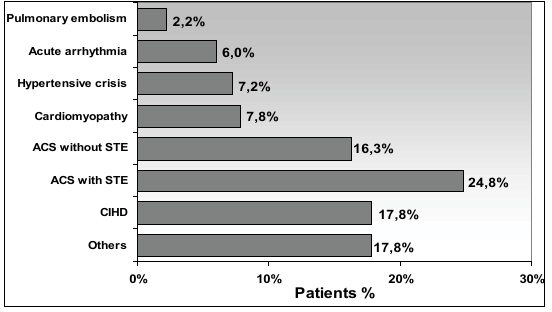
Table 1. Baseline characteristics. Figure 1. Aetiology of acute heart